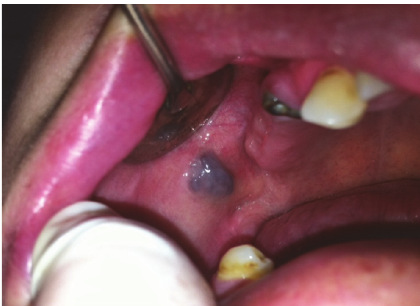
Figure 2: First intralesional injection of aethoxysklerol 0.75%.